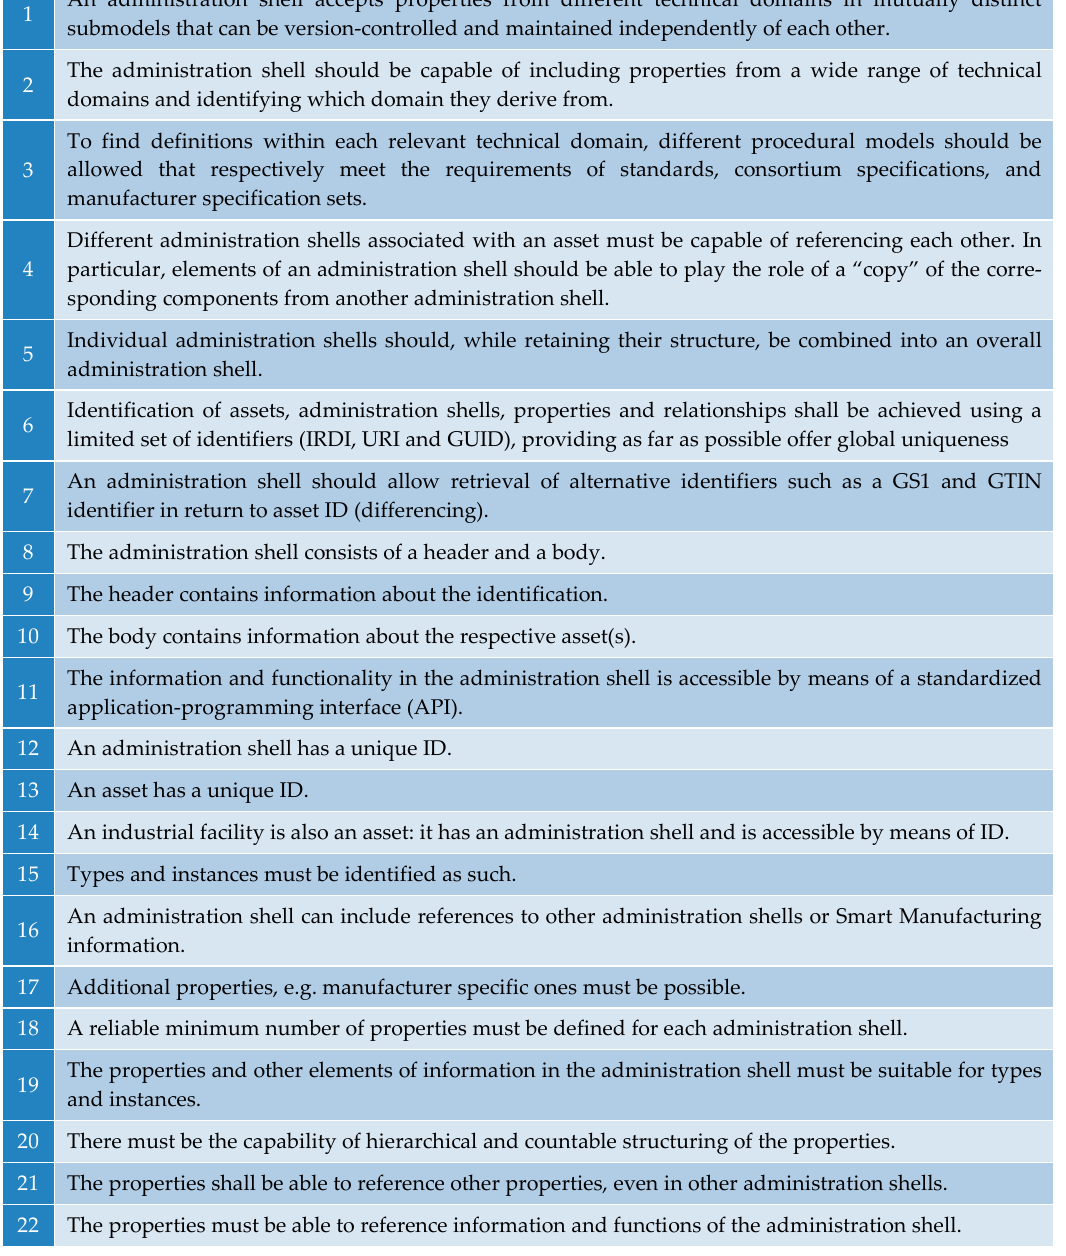
Figure 5. The requirements on the Asset Administration Shell (inspired by [19]).